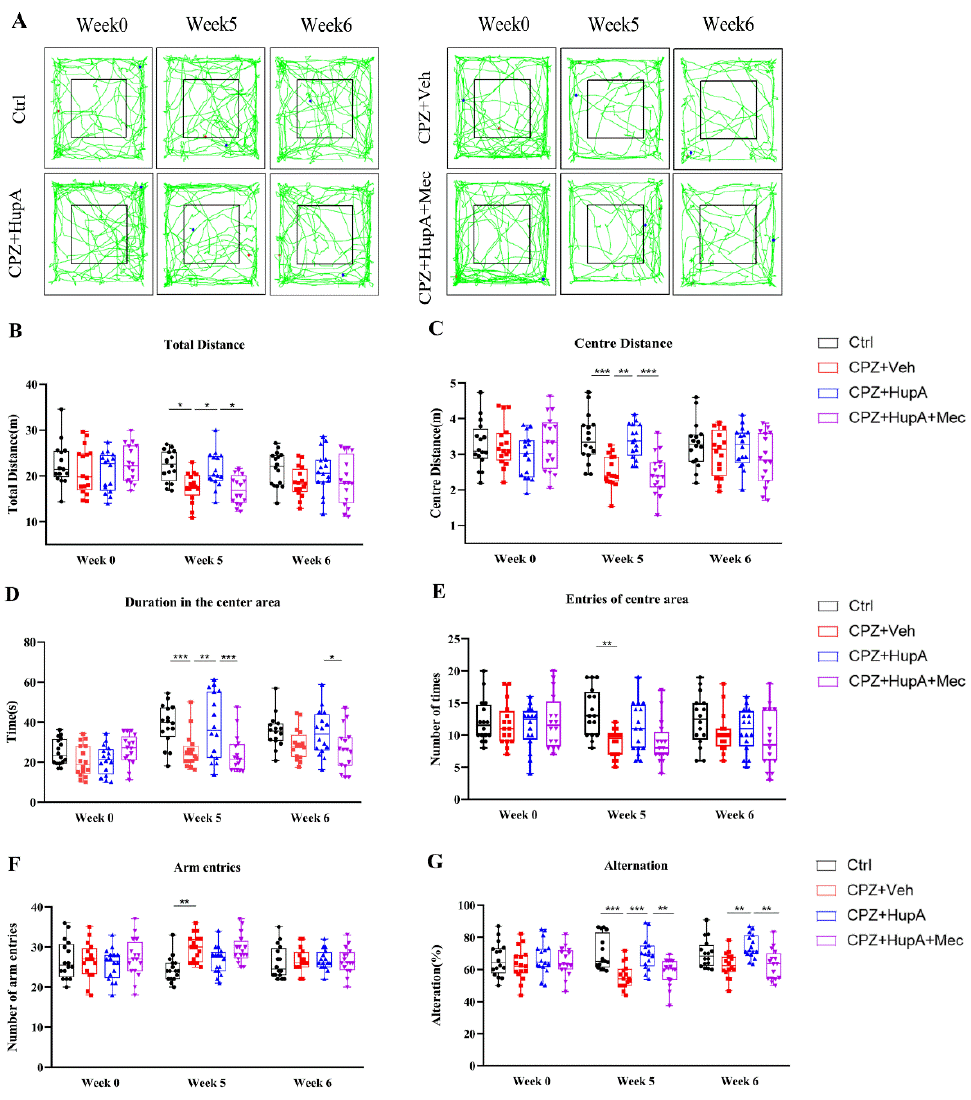
Figure 2. HupA improved anxiety-like symptoms and enhanced memory in demyelinated mice. ( A ) Representative images demonstrated typical cases of exploratory behavior in OFT among the four groups, containing total distance ( B ), center distance ( C ), duration of the movement in the central area ( D ), and entries of center area ( E ) in open field test during 5 min. All the mice were tested in a Y maze test for 8 min, including arm entries ( F ); spontaneous alternative ( G ). The results represent the mean ± SEM (* p < 0.05, ** p < 0.01, *** p < 0.001, n = 16 mice per group).